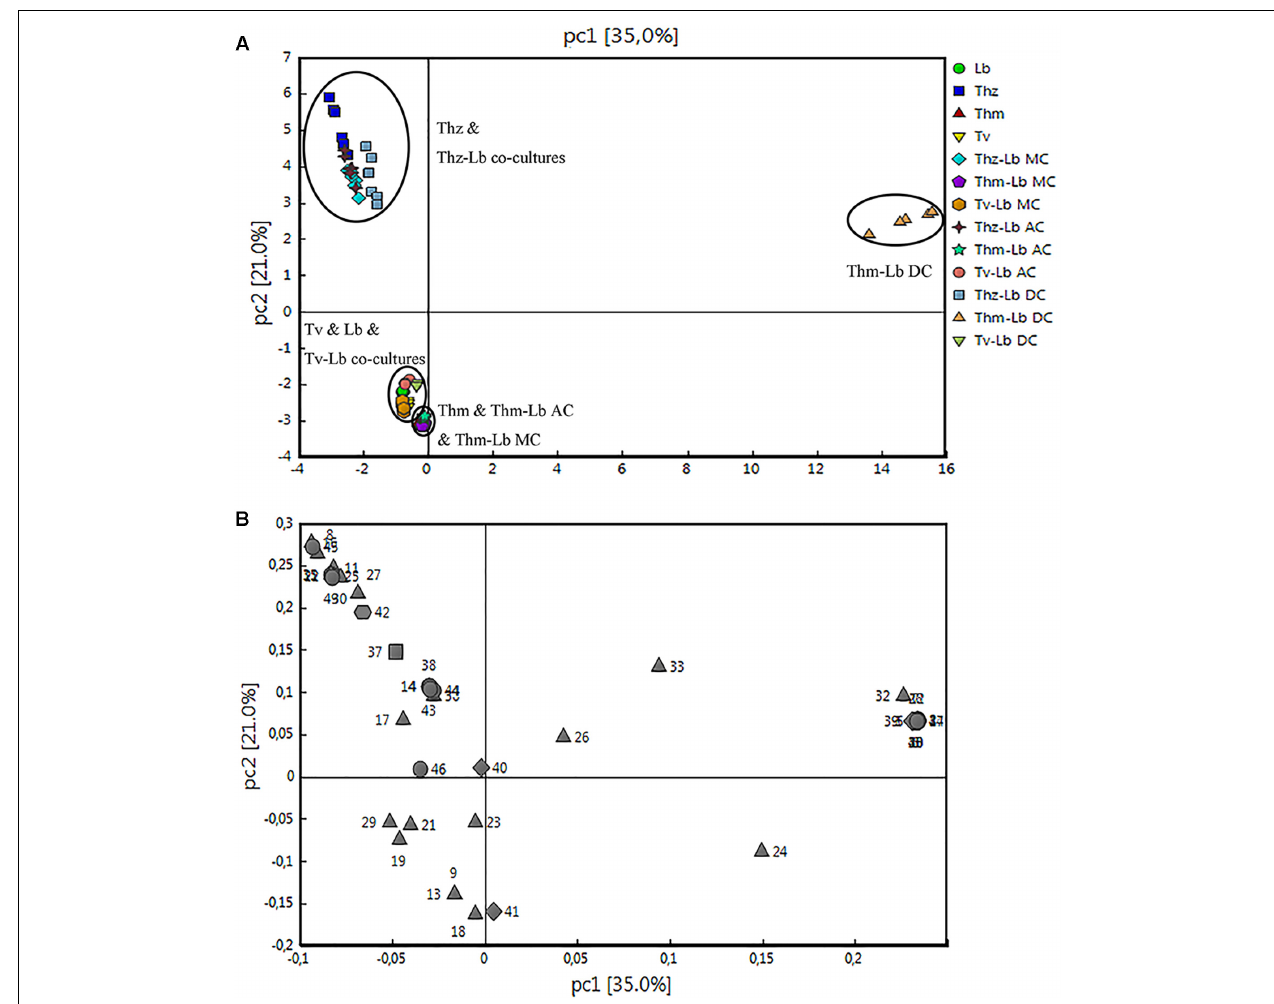
FIGURE 7 | Principal component analysis of the volatile organic compound emission patterns released from T. harzianum (Thz), T. hamatum (Thm), and T. velutinum (Tv) co-cultivated with L. bicolor (Lb). The scores (A) of the first two principal components (PC 1 and PC2) for the different species and co-cultivations are presented with the loadings (B) . The detected compounds were divided into five different chemical groups (loading plot): diamond, monoterpene; hexagon, oxygenated monoterpene; triangle, sesquiterpene; square, oxygenated sesquiterpenes; circle, other